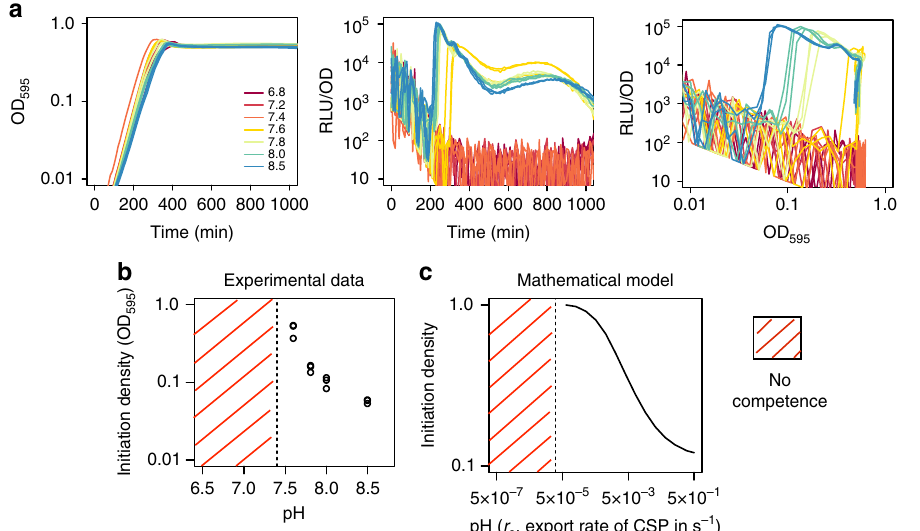
Fig. 4 Competence is upregulated by higher pH. a Effect of initial medium pH on growth curves ( left panel ) and the dynamics of competence expression ( middle panel ). Competence expression was quanti fi ed as relative luminescence units ( RLU ) normalized by cell density. In the right panel , competence expression is plotted in relation to cell density. All populations were grown at the indicated initial pH and inoculated at a density of OD 595nm 0.002. Three replicates are shown for each initial pH. b Effect of initial medium pH on the population density at which competence was initiated (the density at which RLU exceeded 200 units). Competence did not develop at pH 7.4 and below. Note that the indicated pH is the initial pH of the medium, which does not stay constant due to acidi fi cation by growth (Supplementary Fig. 7). Although the pH drops considerably in fully grown cultures, acidi fi cation is still minor at the density where competence develops. c Predictions of the model on the effect of the rate of CSP export, r e , and thus the pH, on the density of competence initiation. Competence does not develop any more below a threshold rate of CSP